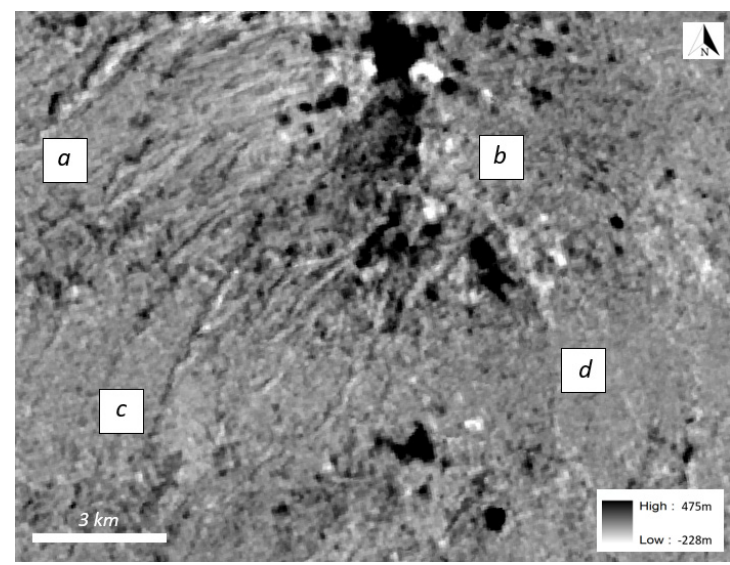
Figure 7. Difference image (ASTER GDEM minus an individual scene ASTER DEM from 24 January 2018). The extreme high and low values in this image are the result of clouds (erroneous topographic highs) and cloud shadows (erroneous topographic lows). Four regions of interest (ROI) (white boxes) were used to calculate the average difference between the two DEMs. ROI were chosen to avoid complications from the small areas of cloud cover, cloud shadow, and larger-scale topographic shadowing.